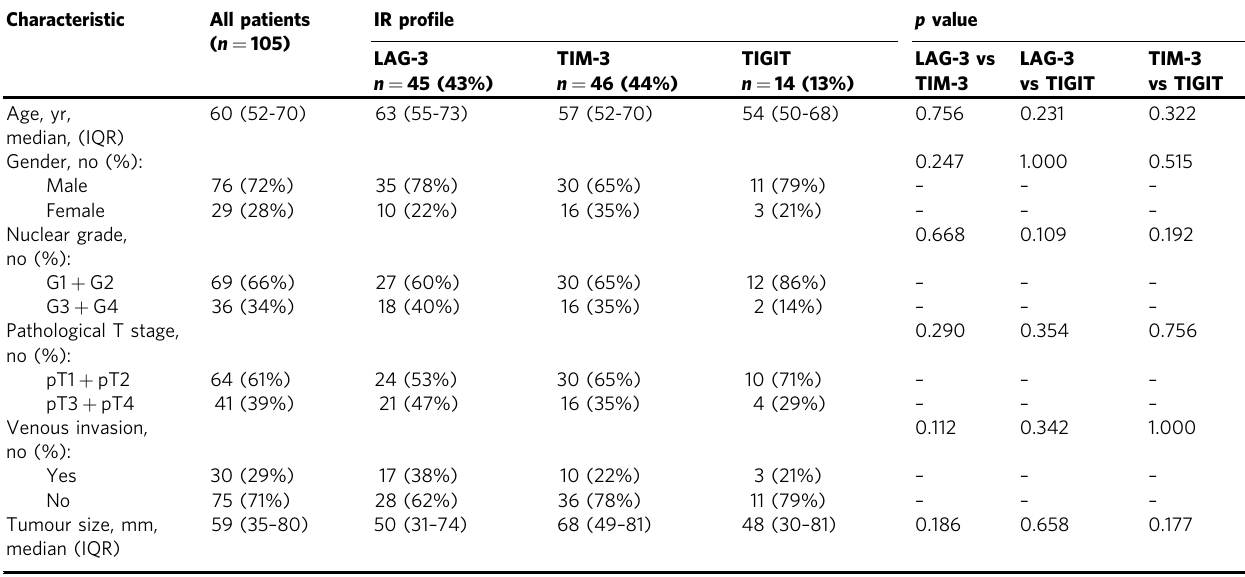
Table 1 Clinicopathological characteristics associated with the phenotypic signatures of the new IRs (LAG-3, TIM-3, and TIGIT) in 105 primary ccRCC tumour samples (COHORT